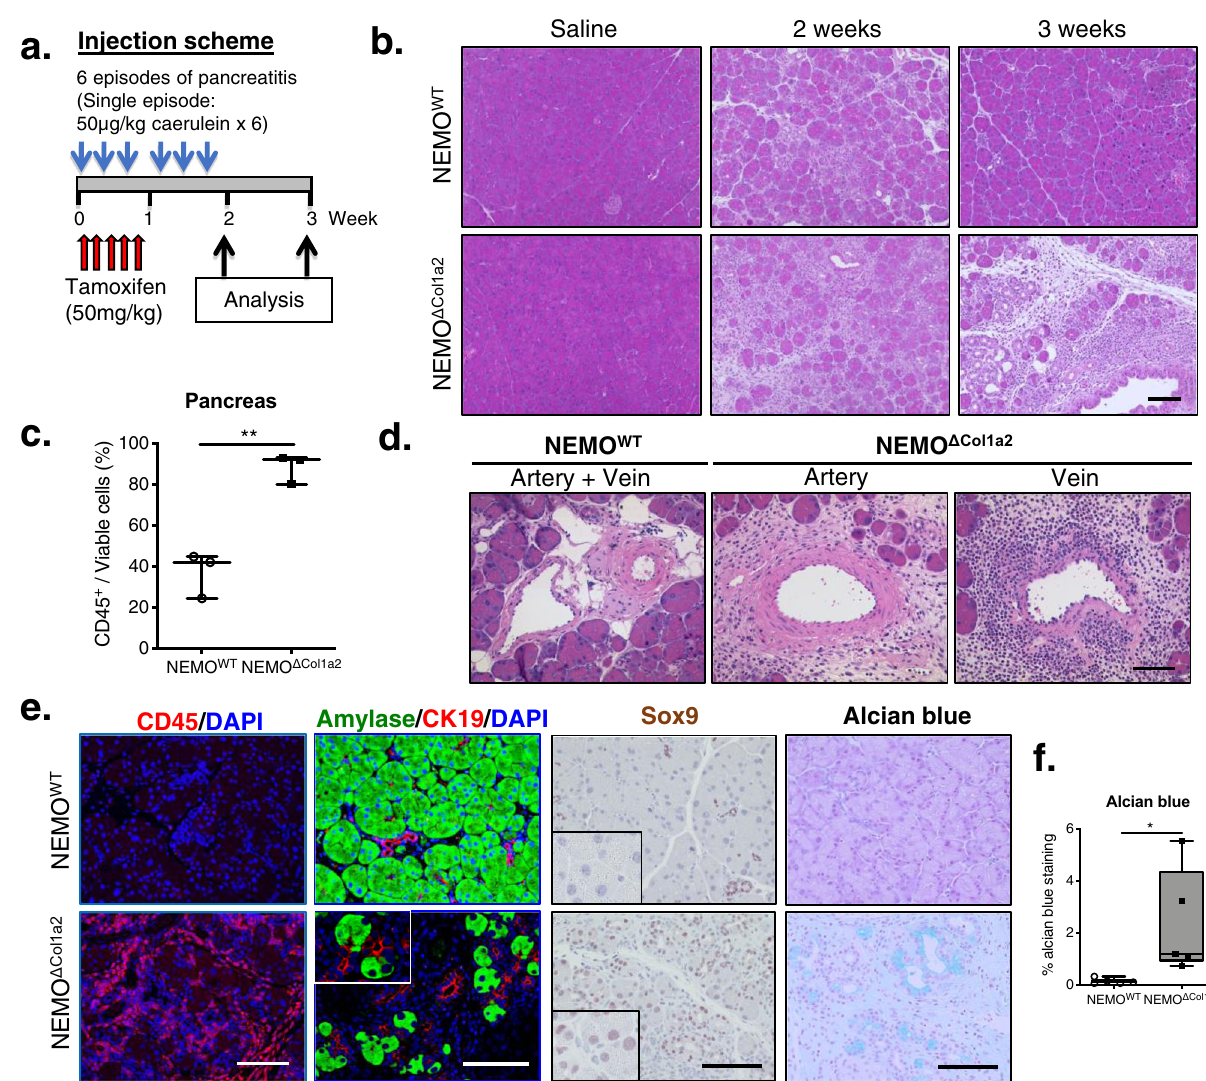
Fig. 2 Deletion of NEMO in PSCs leads to exacerbated caerulein-induced pancreatitis. a Injection scheme of tamoxifen (50 mg/kg daily for fi ve days) and caerulein (6 episodes with each episode consisting of 6 hourly injections of 50 µ g/kg of caerulein). b Pancreata from mice analyzed at the 2-week and 3-week time points. Scale bar: 100 µ m. c In fi ltrating cells from pancreata analyzed by FACS. The percentages of CD45 + /viable cells were measured ( n = 3). d Sporadic venulitits found in NEMO Δ Col1a2 pancreata. Scale bar: 50 µ m. e Staining of pancreatic tissues (3 weeks) for in fi ltrating cells (CD45), markers of transdifferentiation (amylase and CK19; Sox9 in acinar cells) and mucin-producing ductal structures (alcian blue). DAPI: nuclei. Scale bar: 100 µ m. f Quanti fi cation of alcian blue staining as a percentage of area ( n = 5). Whiskers: Min to Max. T -test (two-tailed): * p < 0.05; ** p < 0.01. All n numbers represent biological